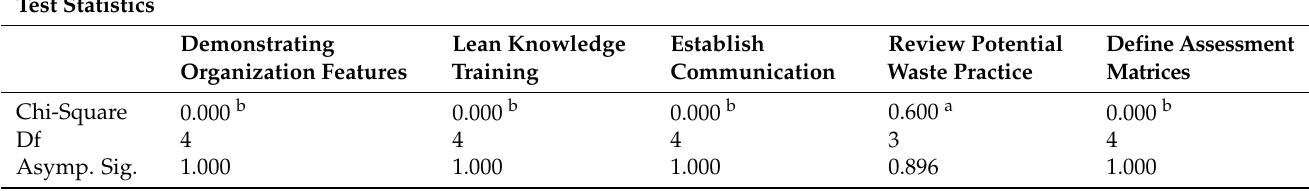
Table 13. Chi-square statistical analysis of parameters of monitoring and controlling quality in the management of construction processes.